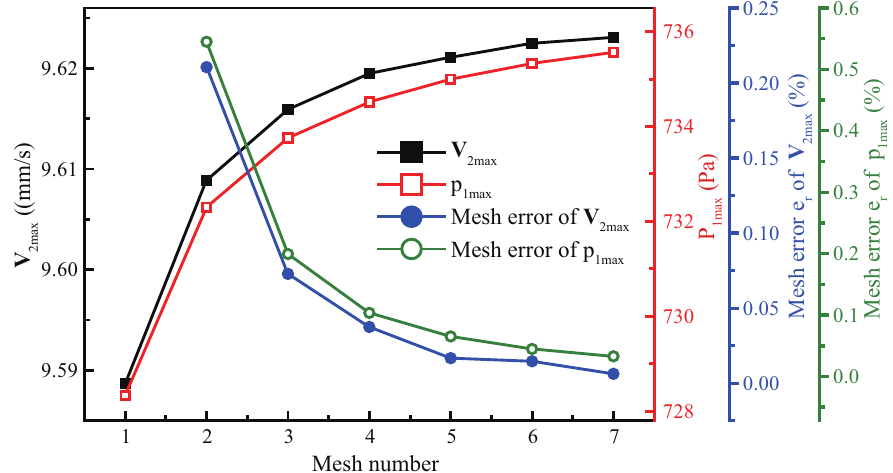
Figure 3. Mesh independence test.The first-order field p 1 max (red line) and the second-order field V 2 max (black line) change with the mesh densification. The blue and green line represent the mesh error of V 2 max and p 1 max as the mesh size decreases